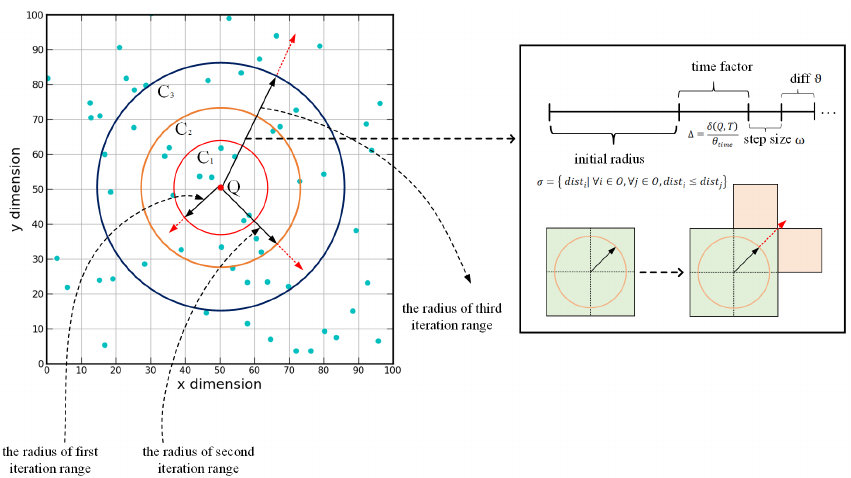
Figure 5. Overview of AIRQ algorithm. The iteration range for each round is a test circle of increasing radius, with each iteration overlapping new data